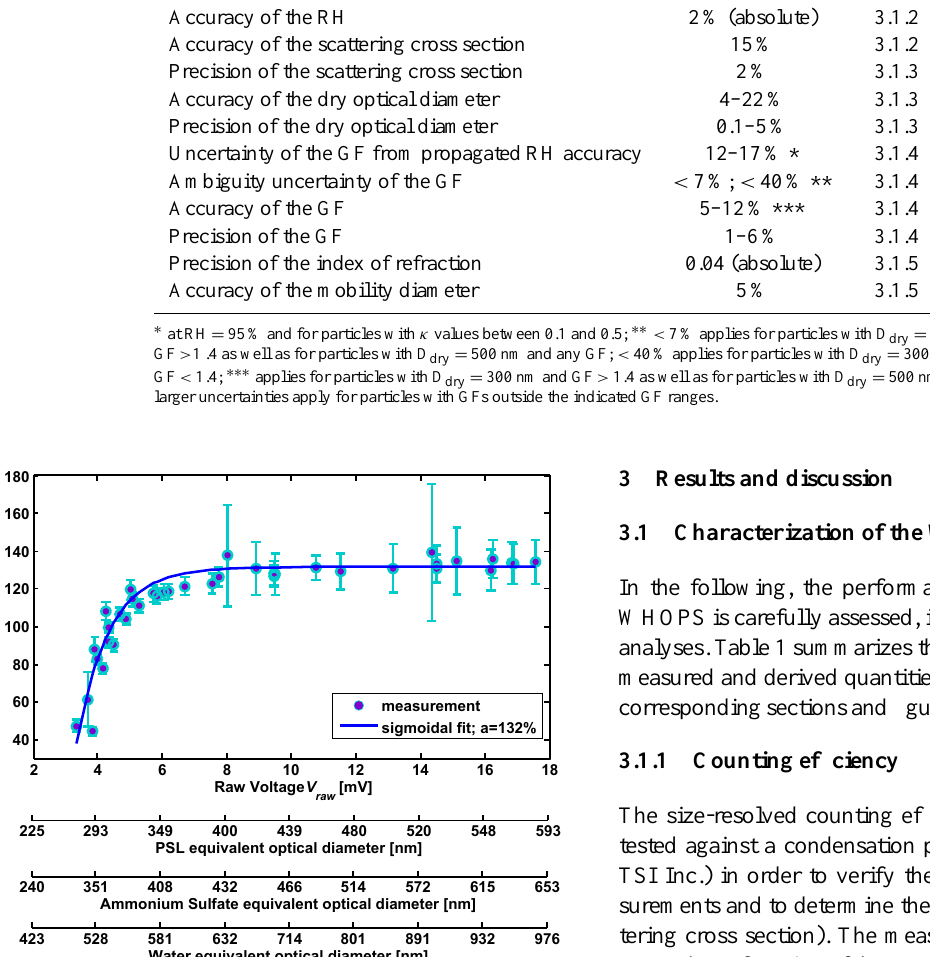
tics. The polydisperse size distribution was recorded for 50